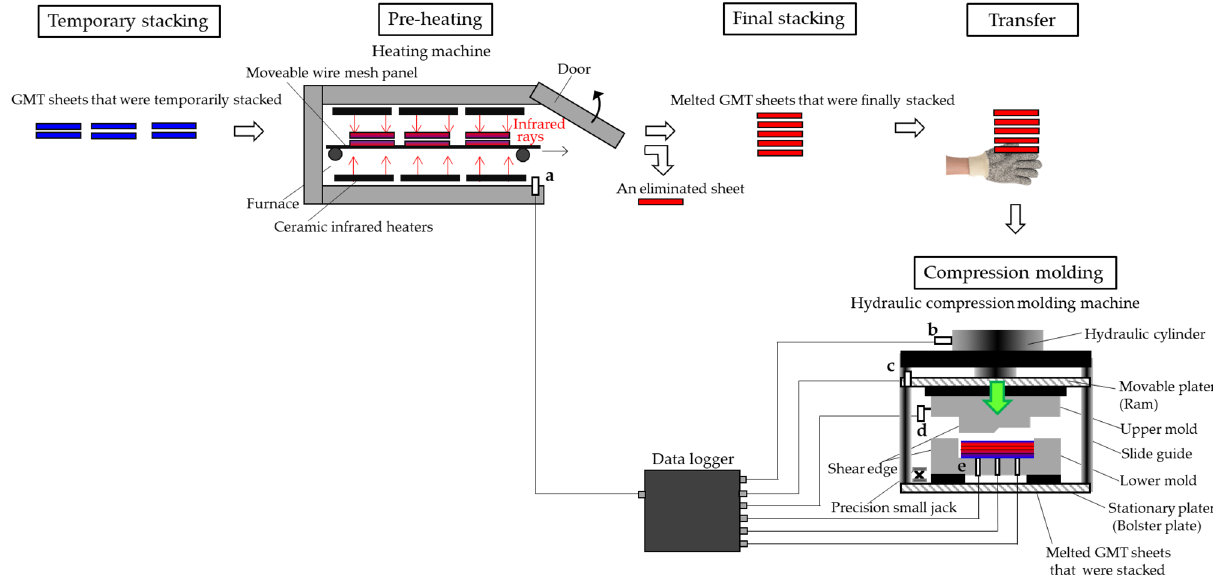
Figure 2. Schematic illustration of test equipment and monitoring system for compression molding in the case of stacking pattern A shown in Figure 5. ( a. temperature sensor with excellent responsivity, b. load sensor, c. long-distance sensor, d. high-precision distance sensor, e. pressure–temperature in-mold sensors).